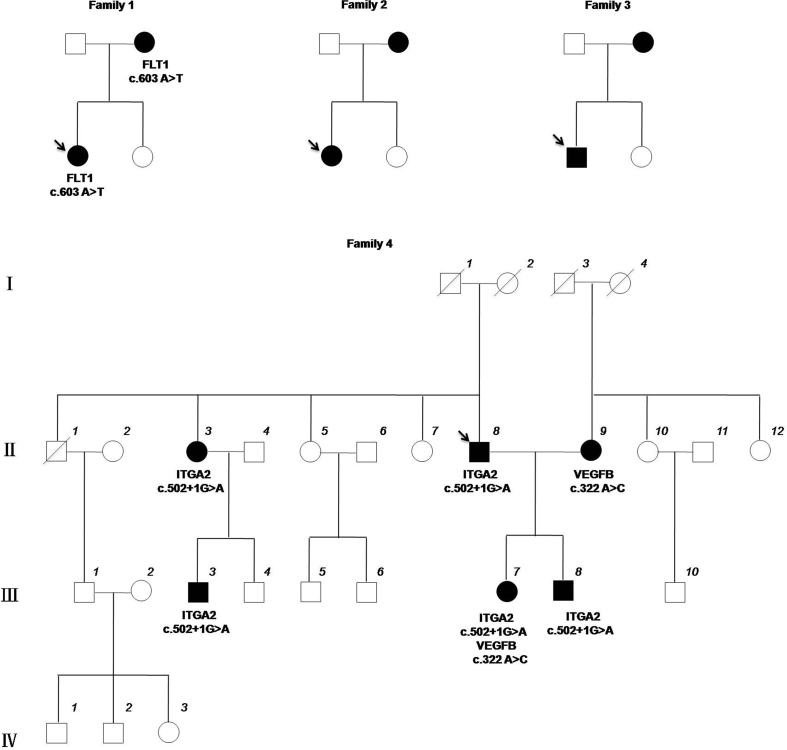
Pedigrees of 4 families with HDM AR. Filled-in symbols indicate individuals with HDM AR, empty circles indicate unaffected individuals, and symbols with a slash through them indicate deceased individuals. Arrow indicates the probands of families. The mutation present in each family is indicated below the corresponding affected individuals.